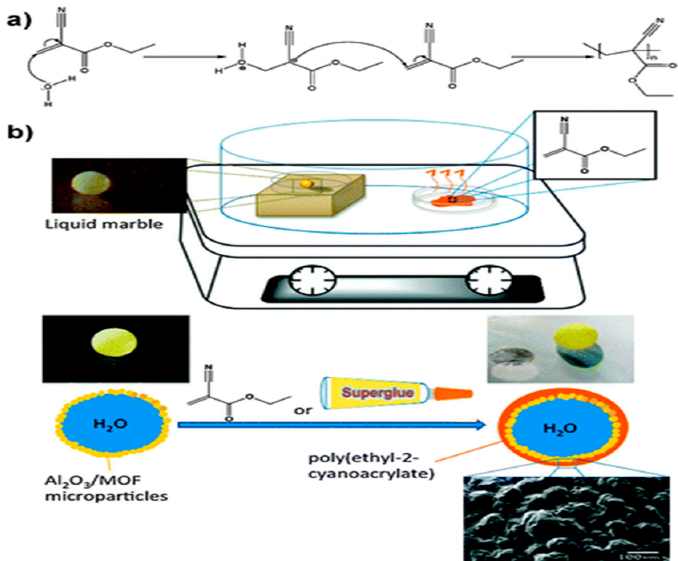
Figure 11. ( a ) Mechanism of cyanoacrylate polymerization; ( b ) Reaction set-up for the interfacial polymerization of ethyl-2-cyanoacrylate on a liquid marble. Heating the hotplate to 80 °C enhances vaporization of the monomer, which condenses on the liquid marble and polymerizes. Reprinted with permission [151] Copyright 2013 Royal Society of Chemistry.